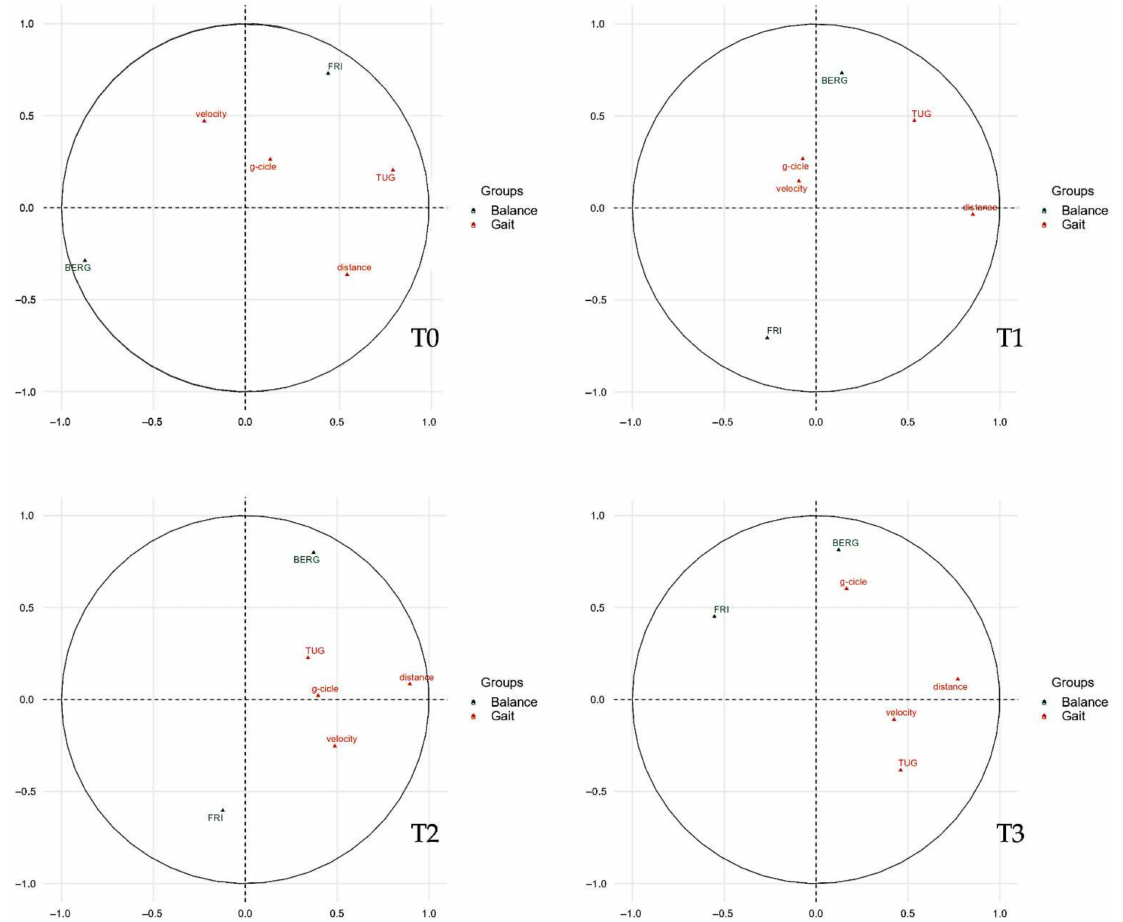
Figure 3. Correlations between quantitative variables and dimensions. The plot depicts the topo- graphical influence in the arrangement of the variables on the graph along the abscissa (Dim1) and the ordinate (Dim2). Abbreviations: BERG: Berg Balance Score; Dim1: dimension 1 (abscissa axis); Dim2, dimension 2 (ordinate axis); g-cycle: gait cycle; TUG: timed up-and-go; FRI: Fall Risk